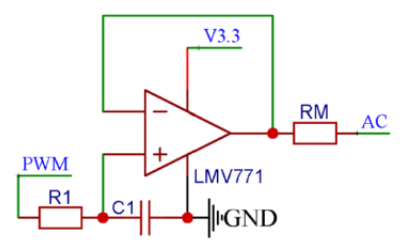
Figure 12. The AC excitation signal generation circuit. To control the voltage signal measured by the inner electrode and the current signal measured by the current electrode in their measurable ranges, the liquid to be tested is matched with a specific RM resistance value. This guarantees that when the conductivity is high, the current signal will not be distorted at the peaks, and when the conductivity is low, the voltage signal will not be distorted at the peaks. The conductivity module uses a differential amplifier circuit to convert two-channel weak internal electrode voltage signals into a single-channel voltage output signal, as shown in Figure 13. A INA333 instrumentation amplifier from Texas Instruments, with the characteristics of low power consumption and high precision, is used in this work, and its gain is obtained by: G = 1 + (100k/R5). This amplifier differentially amplifies the AC voltage signal measured by the inner electrode. By adjusting the resistance value of gain resistor R5, the differential signal is amplified by 26 times, reflecting the voltage difference between the internal electrodes.